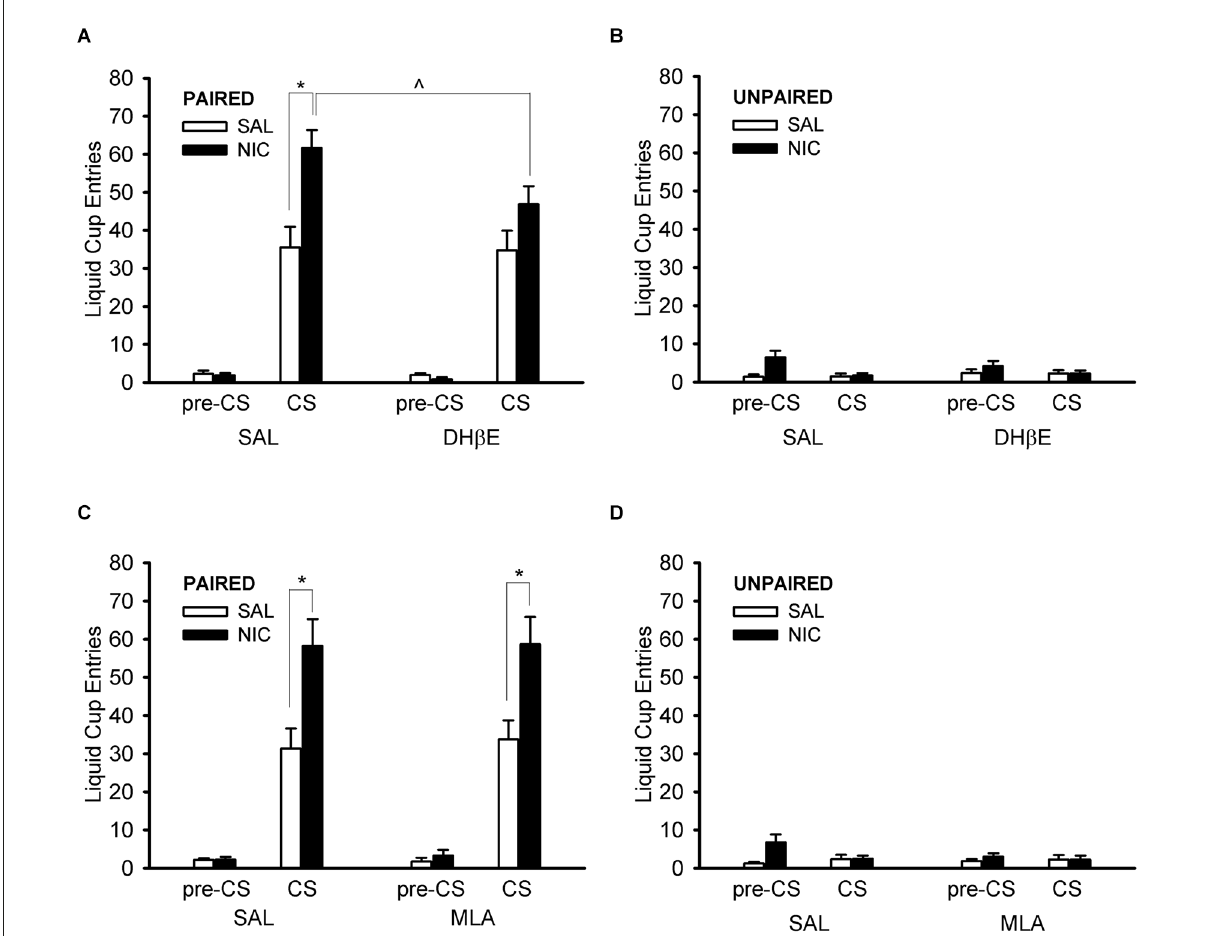
FIGURE5 Pre-treatment with the β 2* nAChR antagonist dihydro-beta-erythroidine (DH β E) attenuated the enhancement of the Pavlovian conditioned response to an alcohol cue caused by nicotine (A) , but the α 7 nAChR antagonist methyllycaconitine (MLA) had no such effect (C) . Data represent the mean ( ± SEM) number of liquid cup entries during the first 9 s of the CS and during a 9-s pre-CS interval for the paired group (A,C) and the unpaired group (B,D) in the within-subject nAChR antagonist test sessions. Black bars denote nicotine (NIC) treatment and white bars denote saline (SAL) treatment. * p < 0.05, SAL/NIC > SAL/SAL and MLA/NIC > MLA/SAL. ∧ p < 0.05, DH β E/NIC <